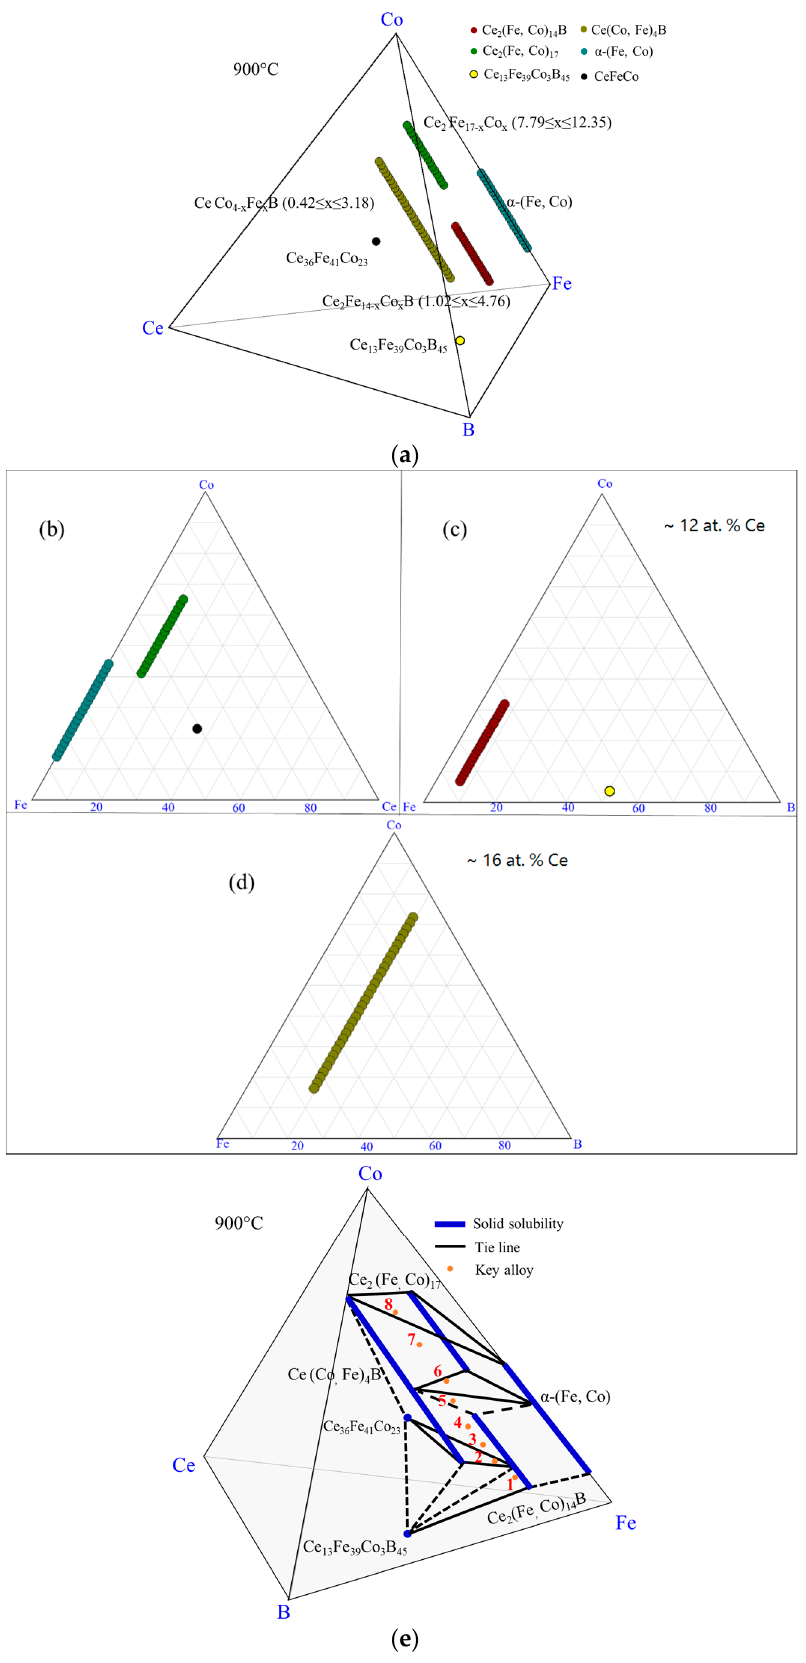
Figure 16. Homogeneity ranges of Ce 2 (Fe, Co) 14 B, and Ce(Co, Fe) 4 B obtained from key alloys: ( a ) 3D presentation of the experimental results; ( b ) Fe-Ce-Co ternary system; ( c ) pseudo ternary section at ~12 at. % Ce; ( d ) pseudo ternary section at ~16 at. % Ce; ( e ) phase relations obtained from KAs 1–8.